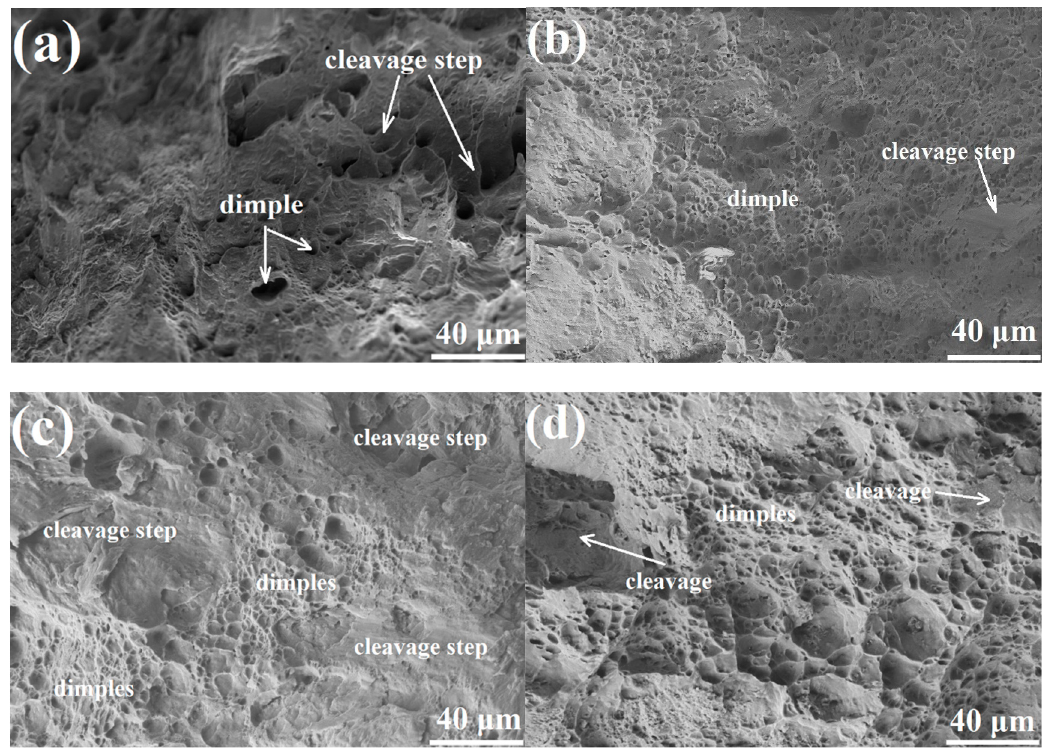
Figure 6. SEM fracture morphology of Mg-9Li alloys: ( a ) Cast alloy; ( b ) E8 alloy; ( c ) CR alloy; and ( d ) E8R alloy.